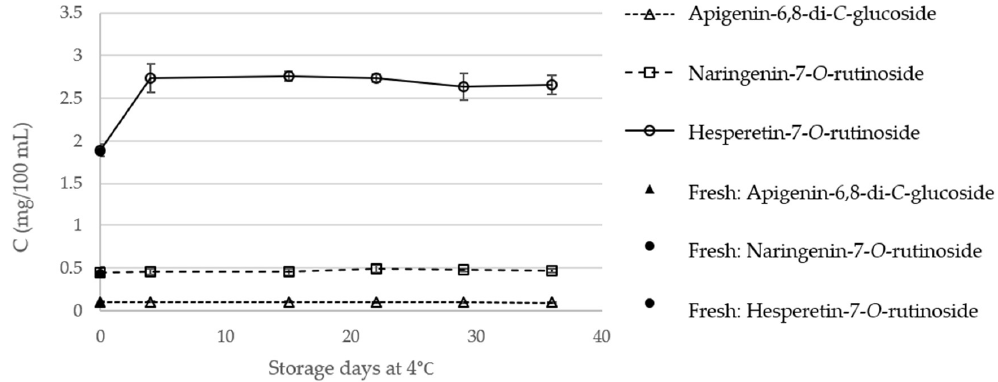
Figure 6. Individual phenolic compounds content (mg/100 mL) of fresh and thermal pasteurized (TP) orange juice during storage at 4 °C.